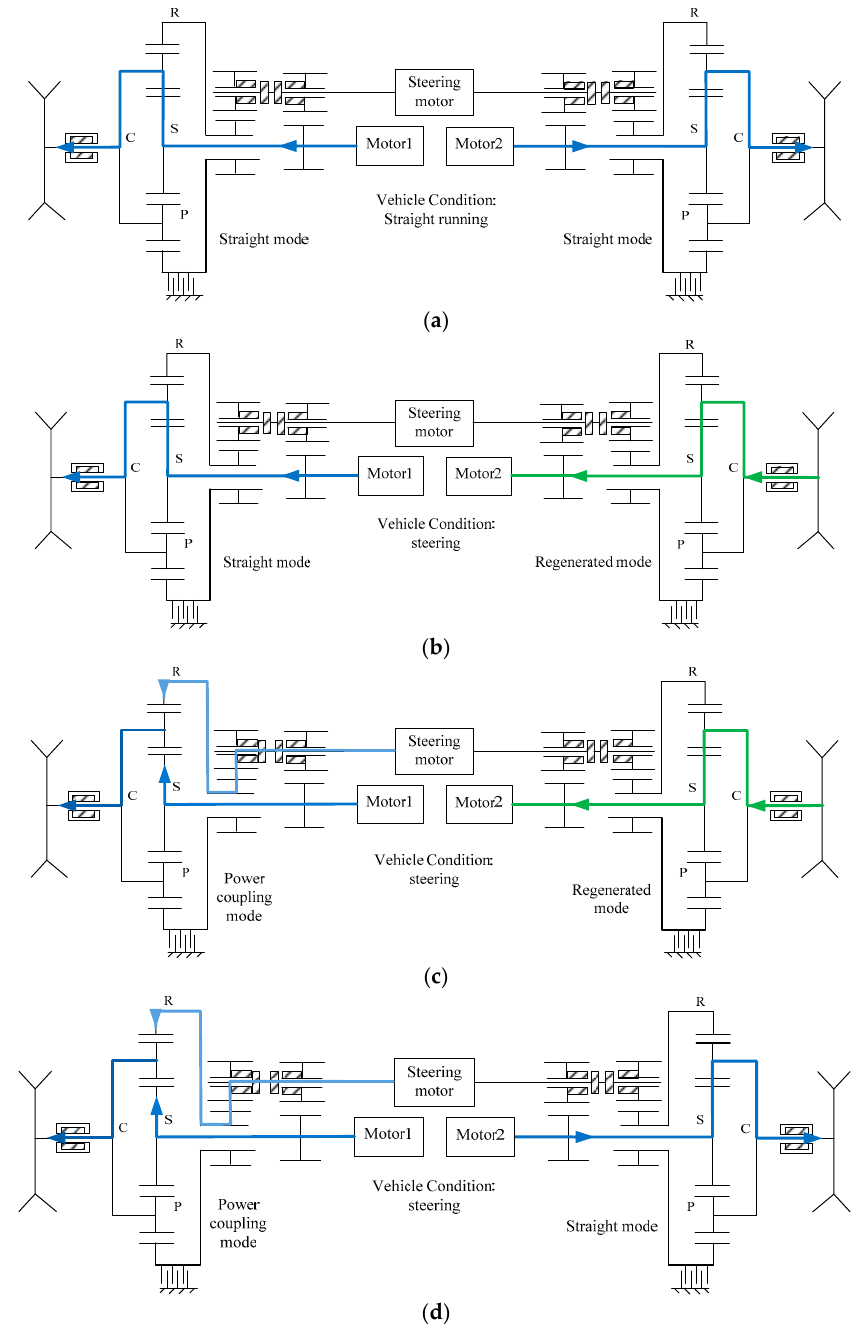
Figure 4. ( a ) Transmission mode during straight running; ( b ) Transmission mode during low speed steering; ( c ) Transmission mode during medium speed steering; ( d ) Transmission mode during high speed